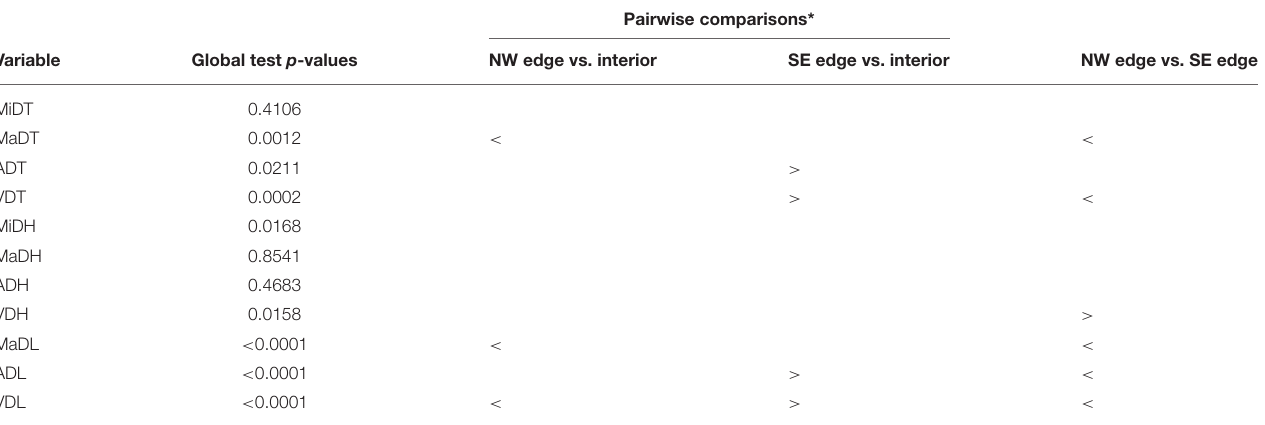
TABLE 2 | Tests of grove